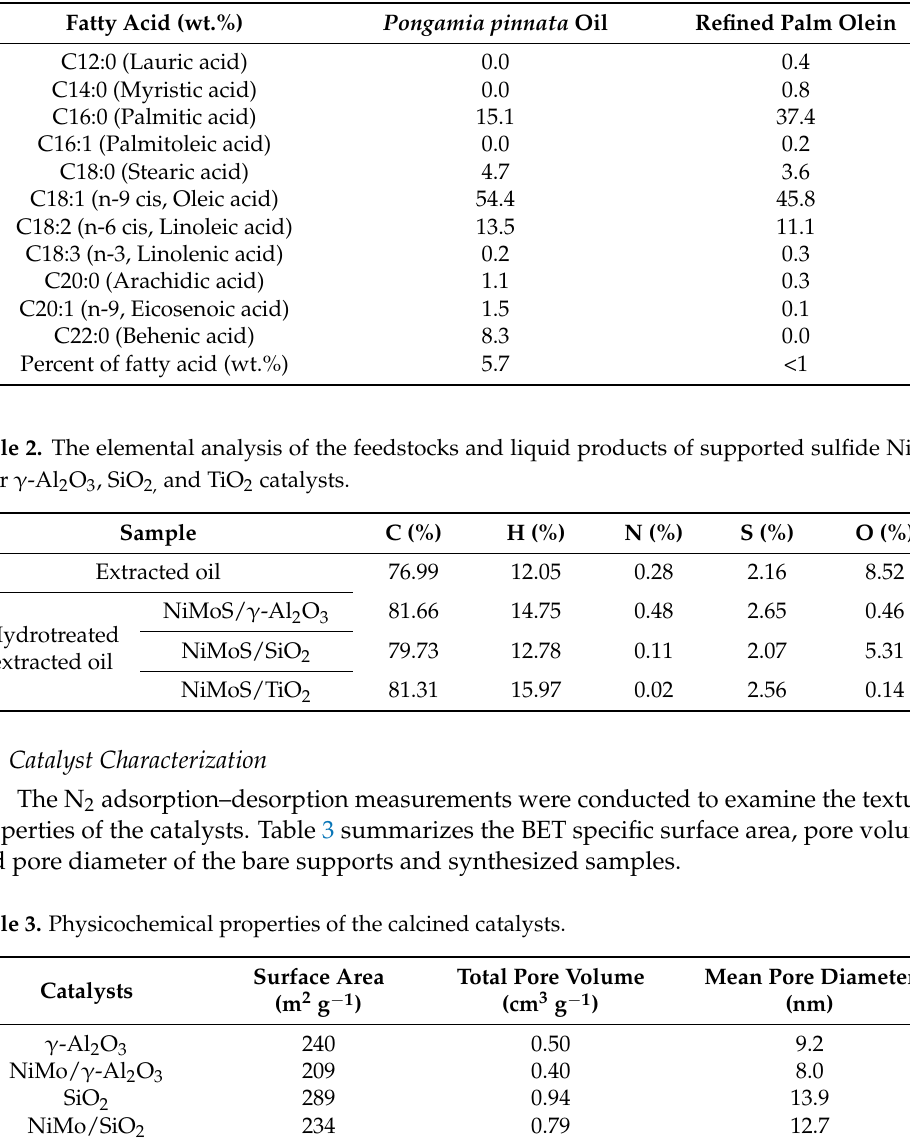
Table 1. The fatty acid distributions of feedstocks.